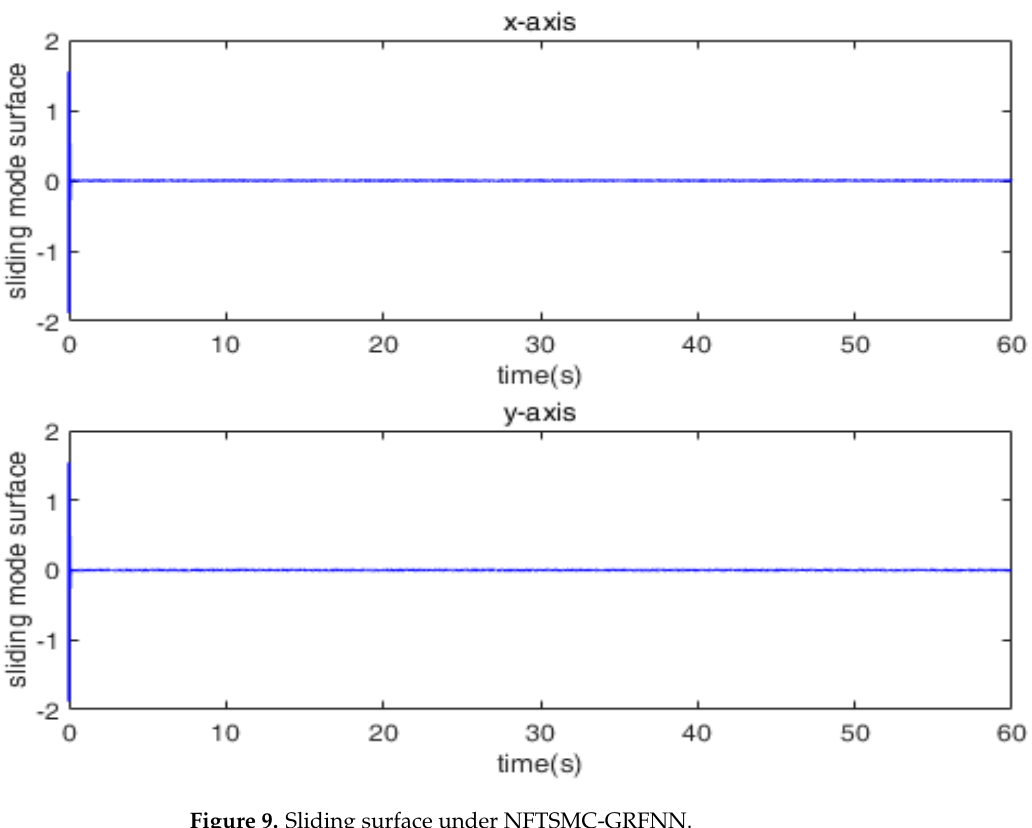
Figure 9. Sliding surface under NFTSMC ‐ GRFNN.